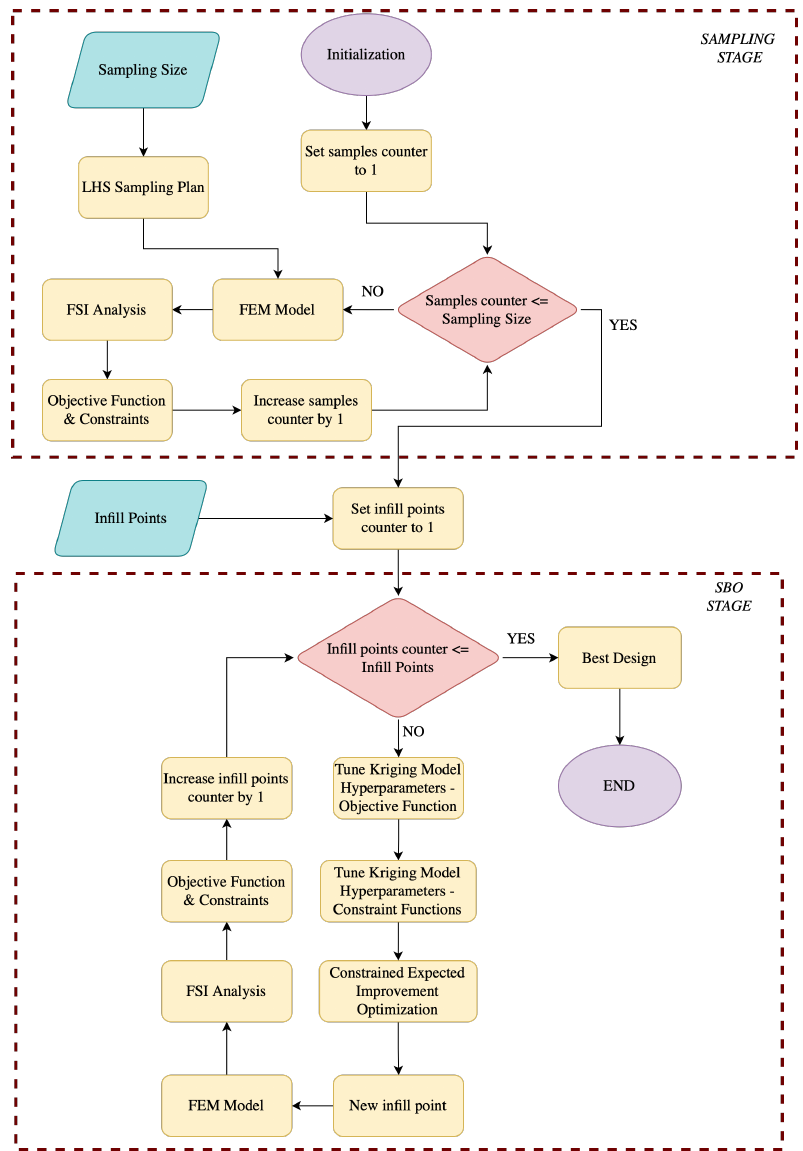
Figure 6. Flowchart of the SBO